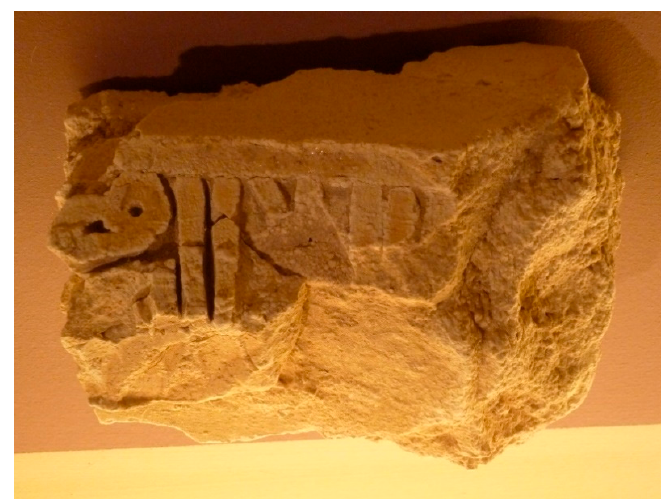
Figure 27. Fragment with Arabic epigraphy, Molina de Aragón Synagogue. Author’s photo.